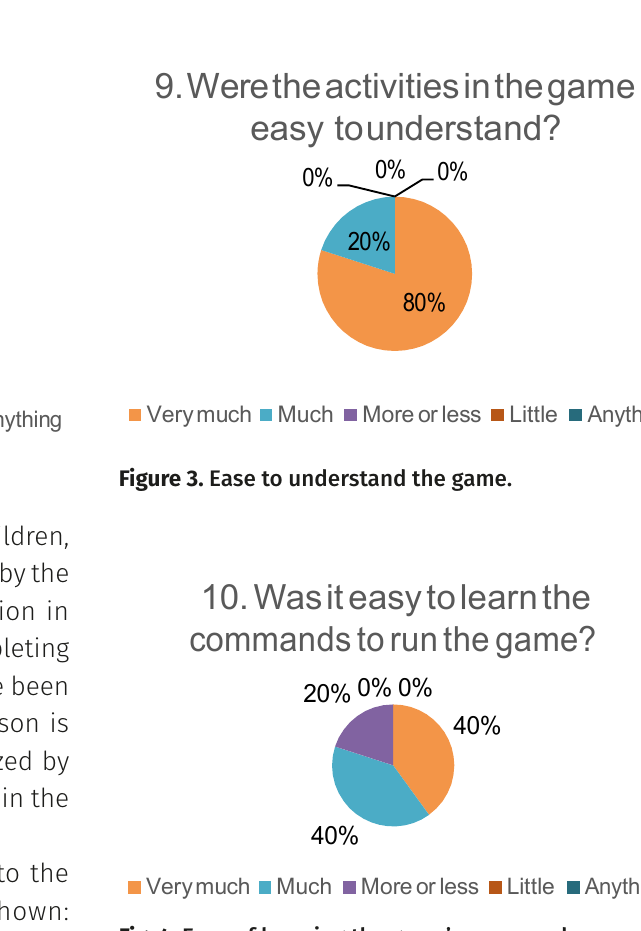
Fig. 4. Ease of learning the game’s